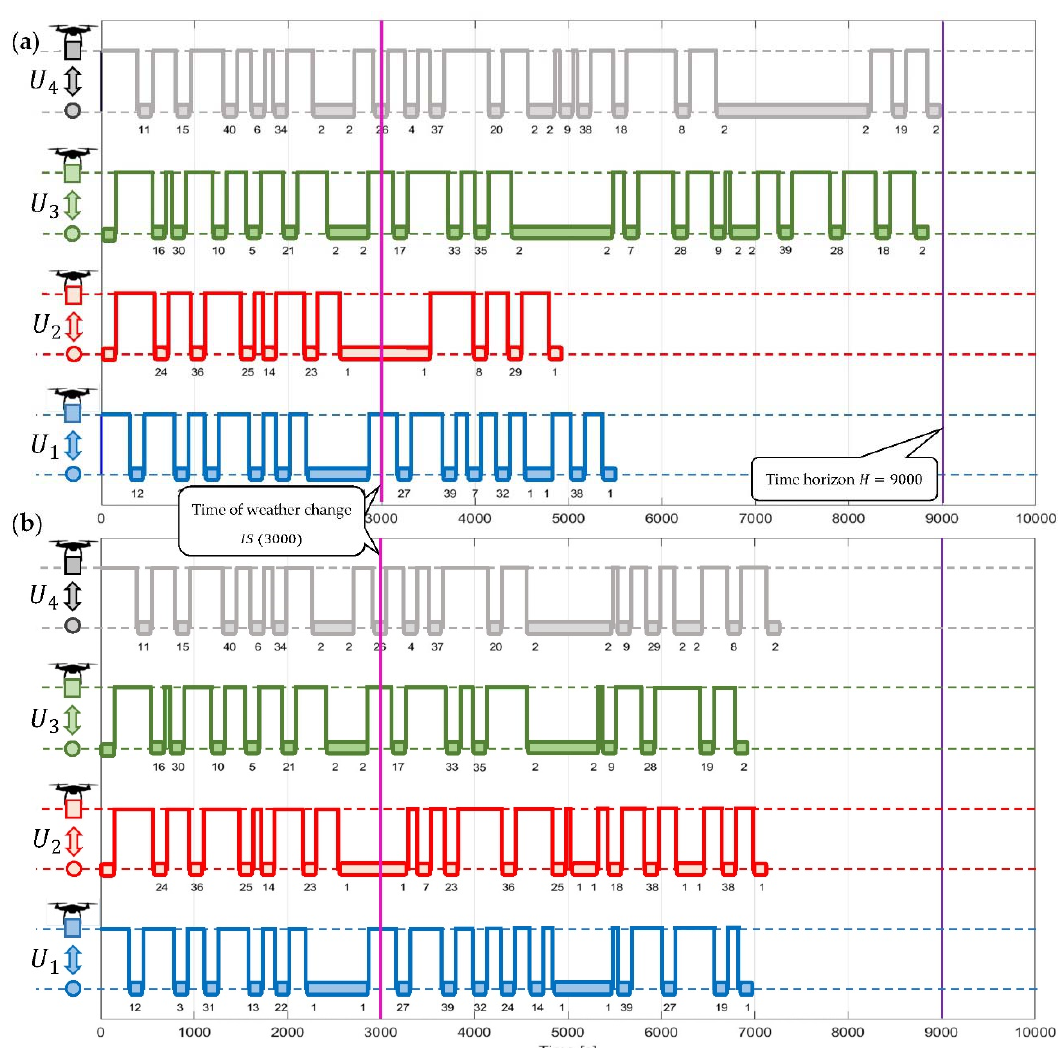
Figure 9. Two kinds of response on the occurrence of a disruption: ( a ) the reaction after a finished mission in the given time window and ( b ) the “ad hoc” reaction.